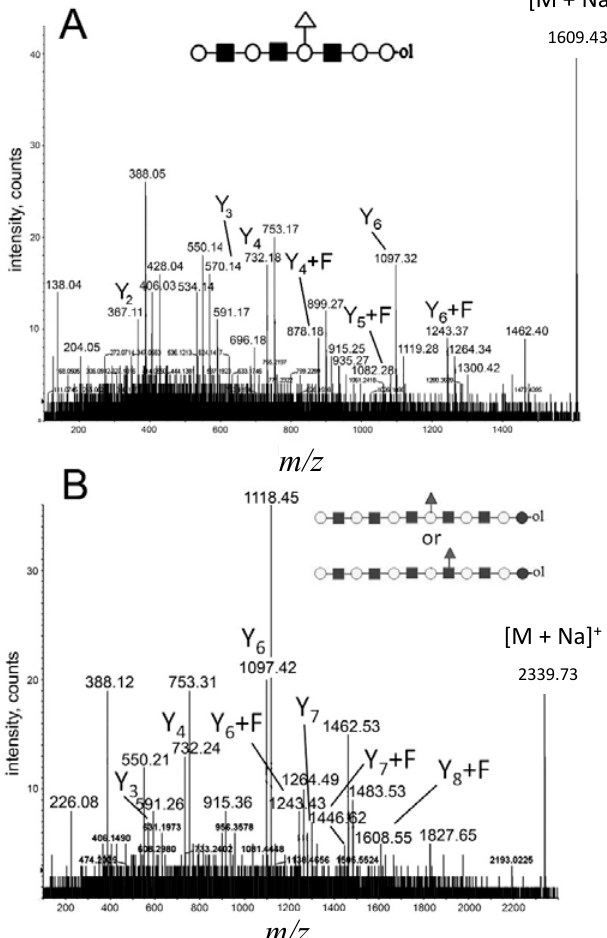
Figure 5. The potentials and limits of fragmentation data using low abundant ions at high m / z values. ( A ) Parent ion at m / z = 1608.43; and ( B ) parent ion at m / z = 2338.73. The spectra were acquired on the AB SCIEX QSTAR ® Pulsar i (see the Experimental Section). [M + Na] +